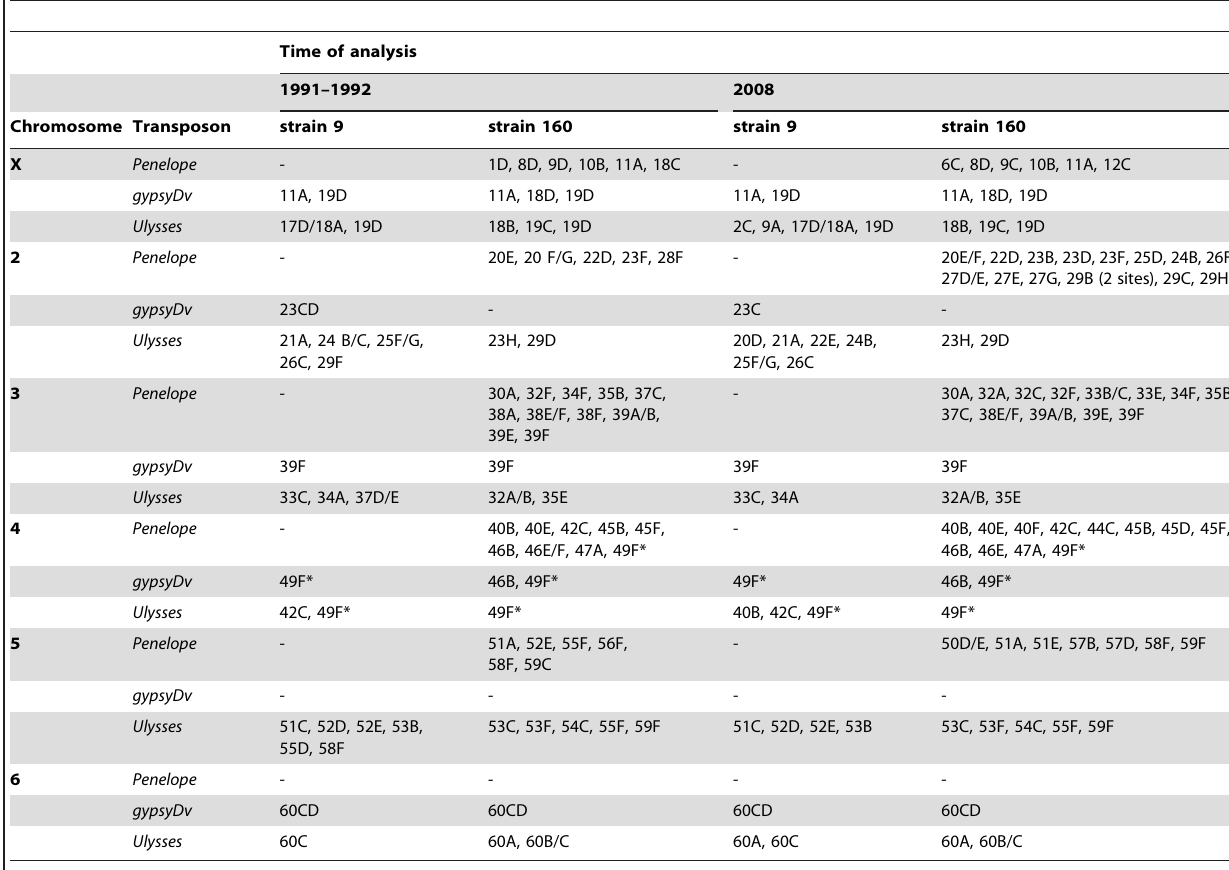
Table 1. Copy number of Penelope , Ulysses and gypsyDv in polytene chromosomes of D. virilis strains 9 and